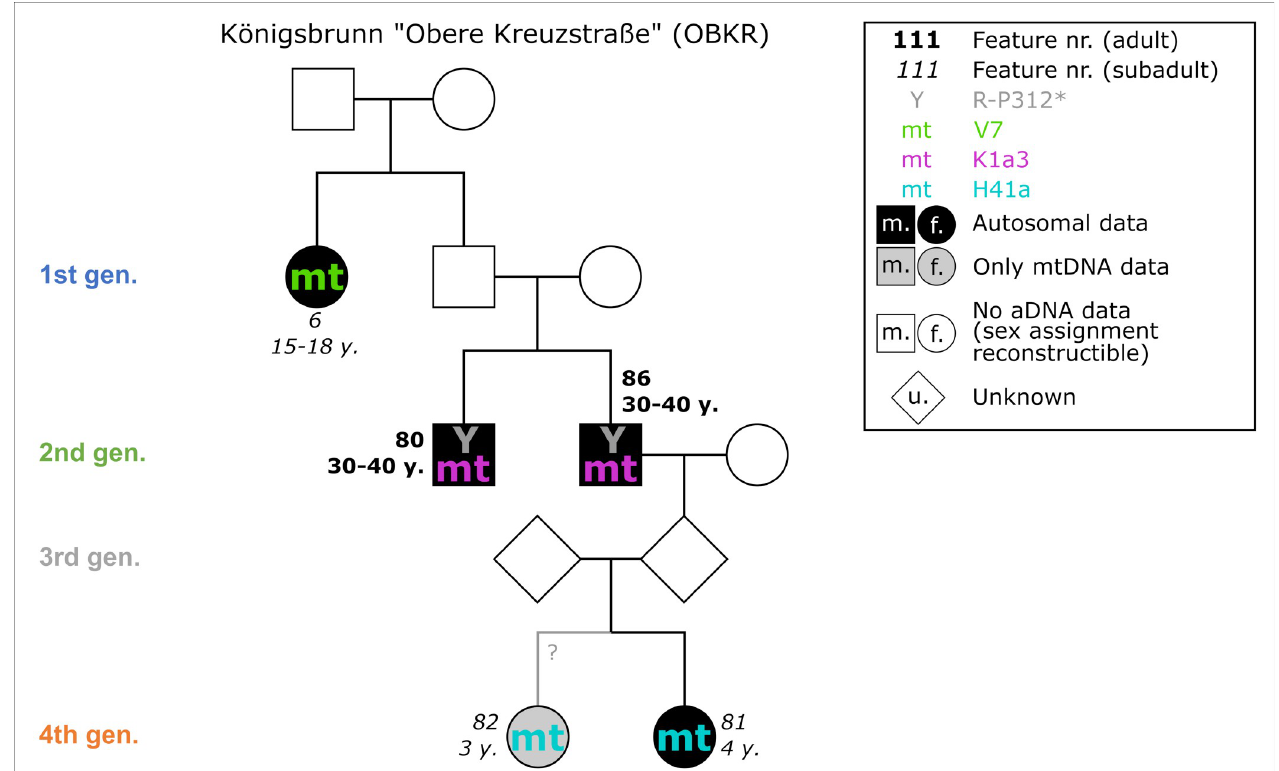
Fig 8. Pedigree of OBKR with four generations based upon evidence from aDNA analysis. Ancient DNA analysis includes the coefficient of relatedness, shared mtDNA haplotypes and Y-haplogroups. Feature number and AaD estimate are depicted alongside the symbol for each individual.